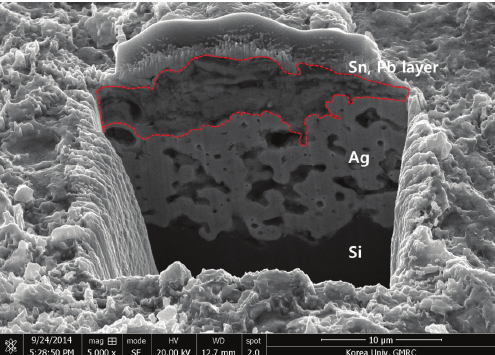
Figure 4: Cross-sectional SEM image of Sn, Pb